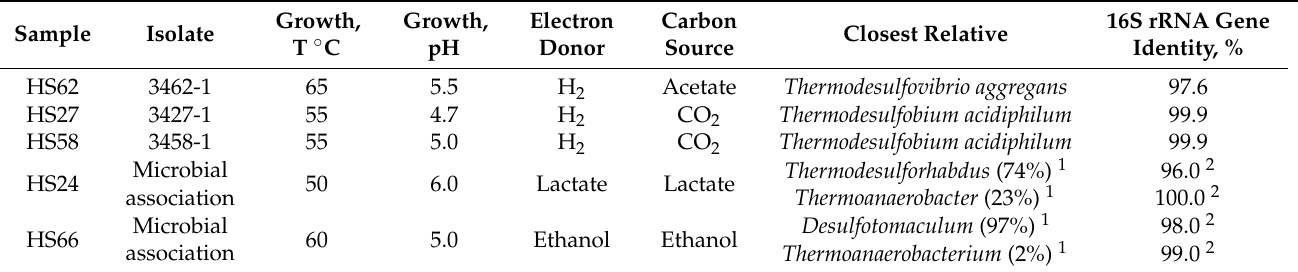
Table 3. SRP isolated from Kamchatka hot